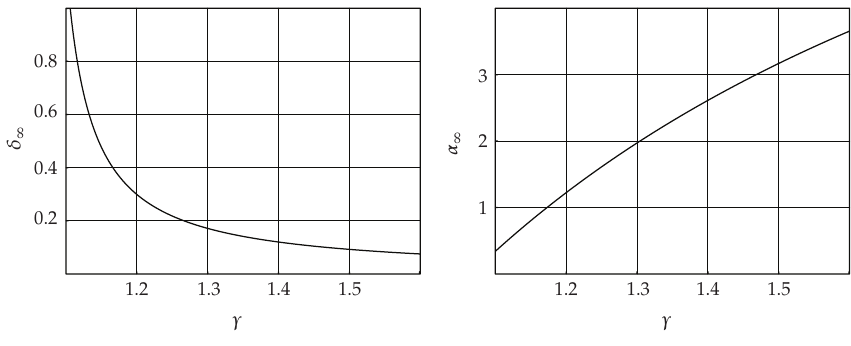
Figure 4: The limit functions δ ∞ (cid:4) γ (cid:7) and α ∞ (cid:4) γ (cid:7)